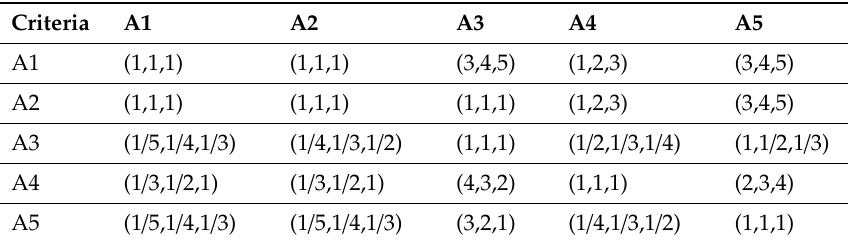
Table 2. Fuzzy comparison matrices for GOAL.